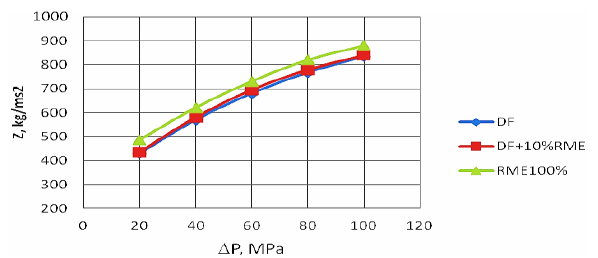
Fig. 3. Acoustic resistance change ( Z ) as a function of the pressure of selected fuels